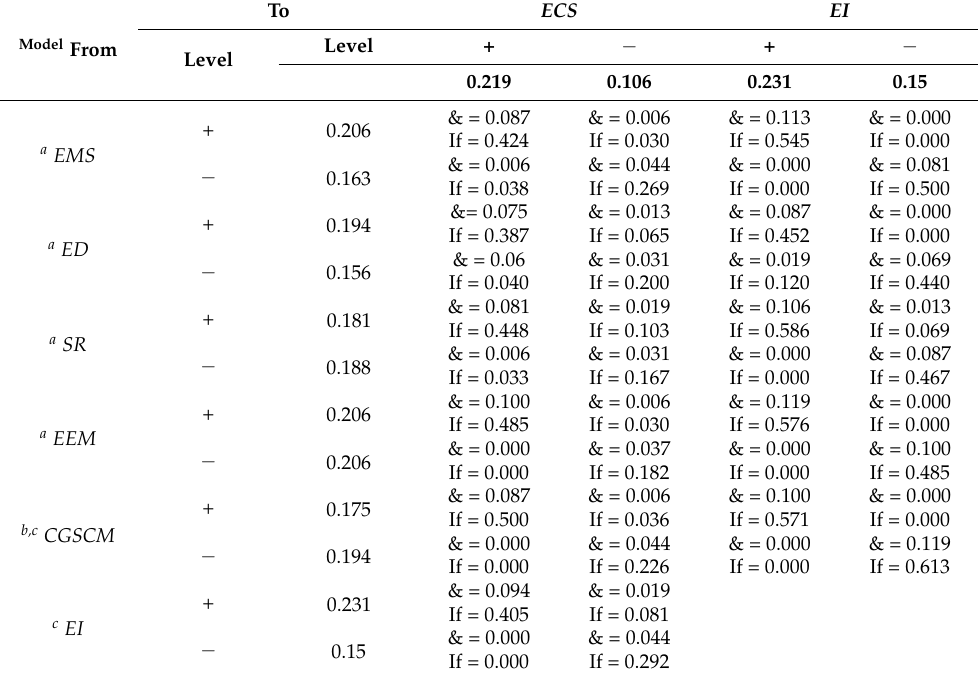
Table 6. Sensitivity